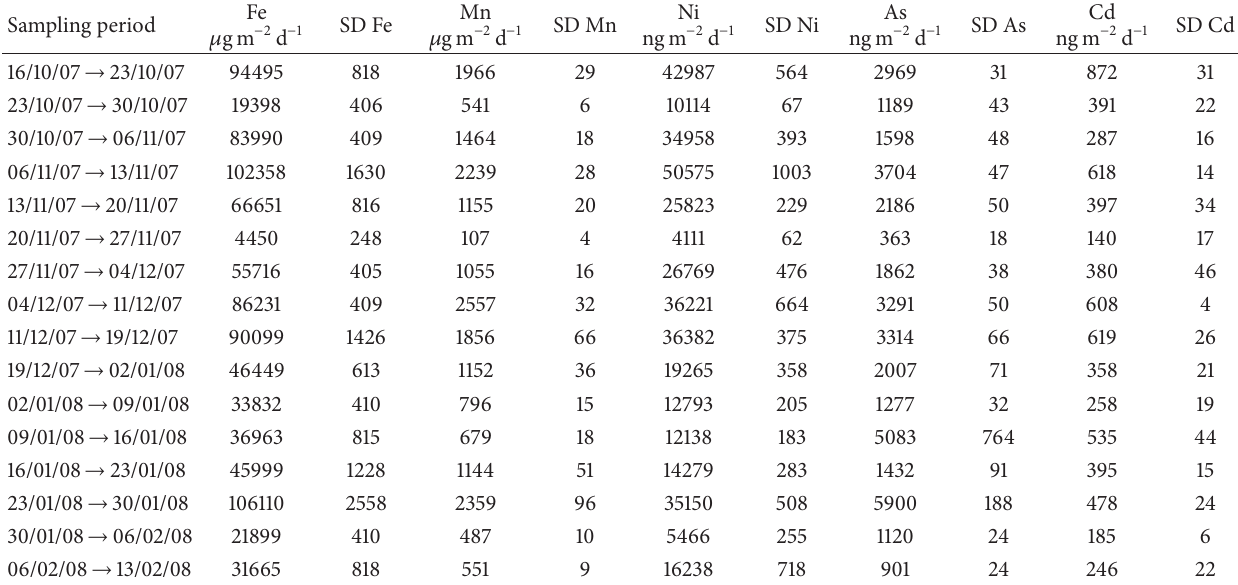
Table 3: Bulk deposition flux and the measurement uncertainty (SD) of Fe and Mn 𝜇 g m − 2 d − 1 and of Ni, As, and Cd ngm − 2 d − 1 for the industrial site.